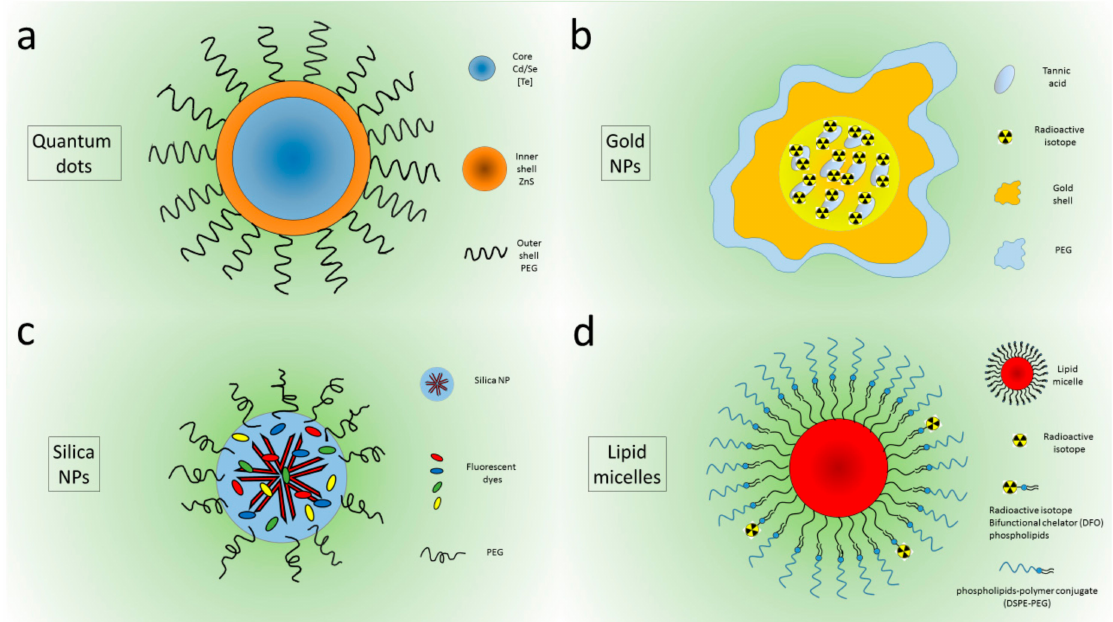
Figure 2. Peghilated Quantum dots ( a ), Au nanoparticles ( b ) Silica Nanoparticles ( c ), micelles ( d